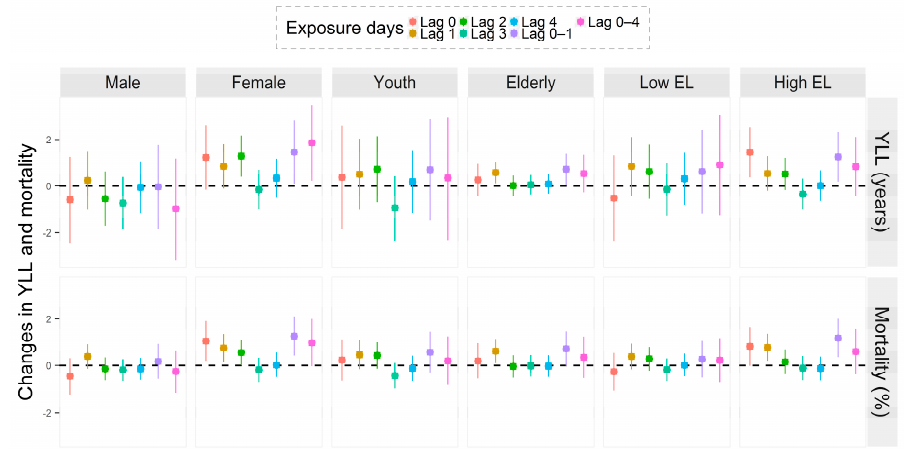
Figure 1. The estimated effects of DTR on subgroup-specific mortality and YLL at different exposure days. The results were presented as changes in daily mortality (%) and YLL (years) associated with a 1 °C increase in DTR. Youth: 0–74 years old; Elderly: 75+ years old; Low EL: 0–6 years’ education level; High EL: 7+ years’ education level.